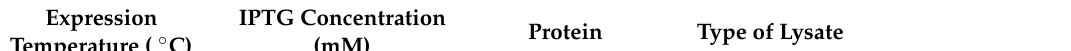
Table 4. Optimization of M2e-NP and mM2e-NP protein